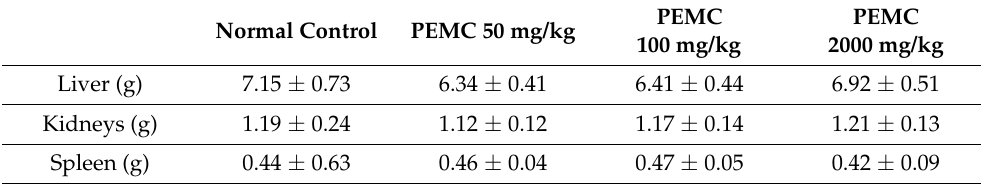
Table 3. The PEMC effect on relative weight (g) of several vital